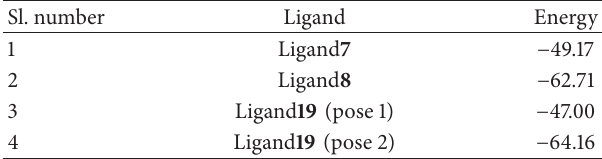
Table 2: Induced Fit Docking